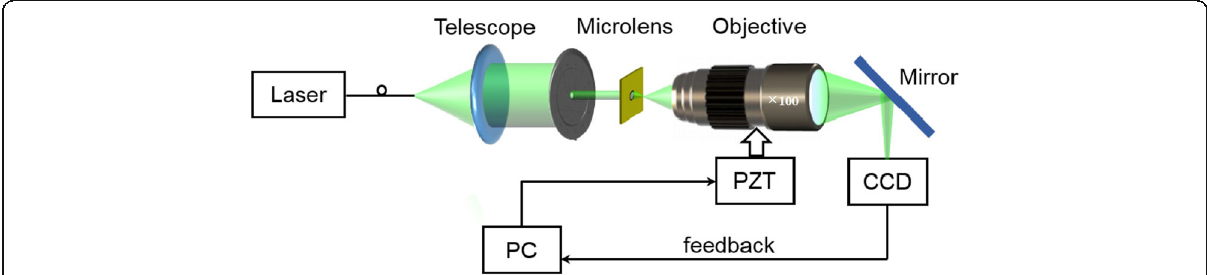
Fig. 4 Experimental setup for characterizing the optical focusing performance of microlenses and their arrays. A 532-nm continuous-wave (CW) laser is expanded via a telescope in order to obtain a homogeneous beam. Passing through the microlens, the transmitted speckle pattern is collected by a microscope objective and measured by a